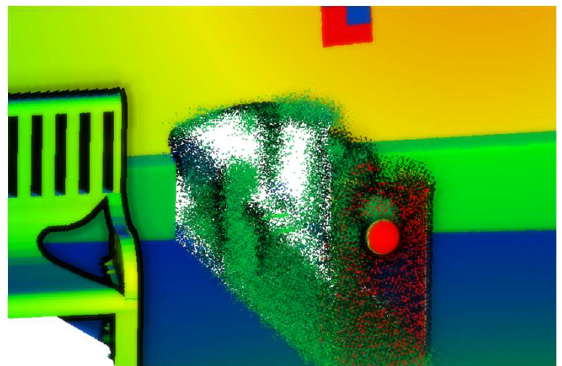
Figure 6. Noise simulation from highly reflective